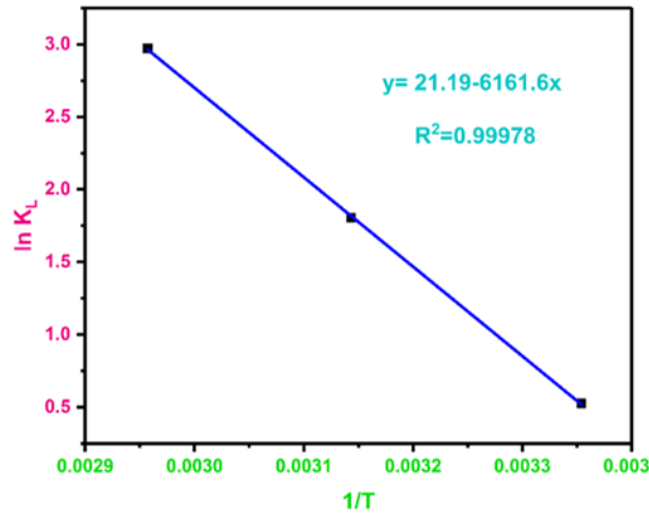
Figure 15. Thermodynamic plot of lnK L versus 1/T for adsorption of BPA on MBC. As the sorption temperature rises, the values of ∆ G ◦ turn out to be more negative, which implies that BPA is better effectively adsorbed to MBC at elevated